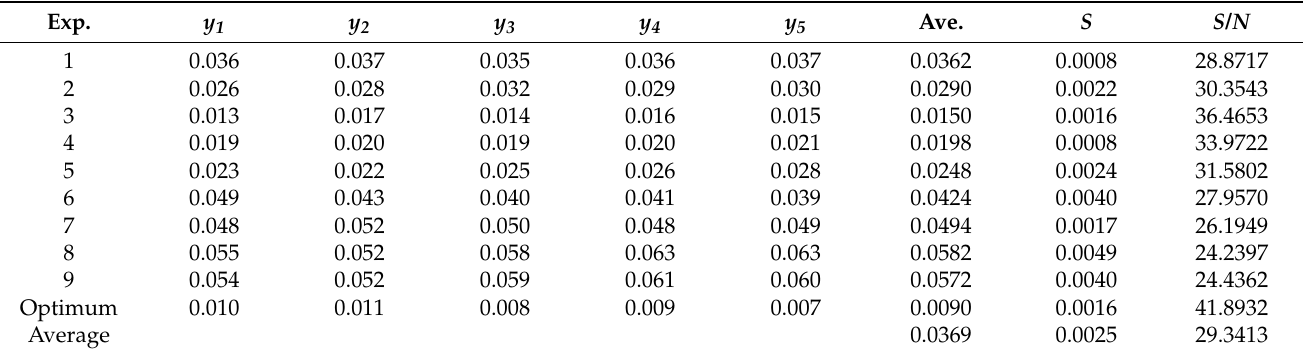
Table 5. S/N ratio of shrinkage of linkage part for the MAV.